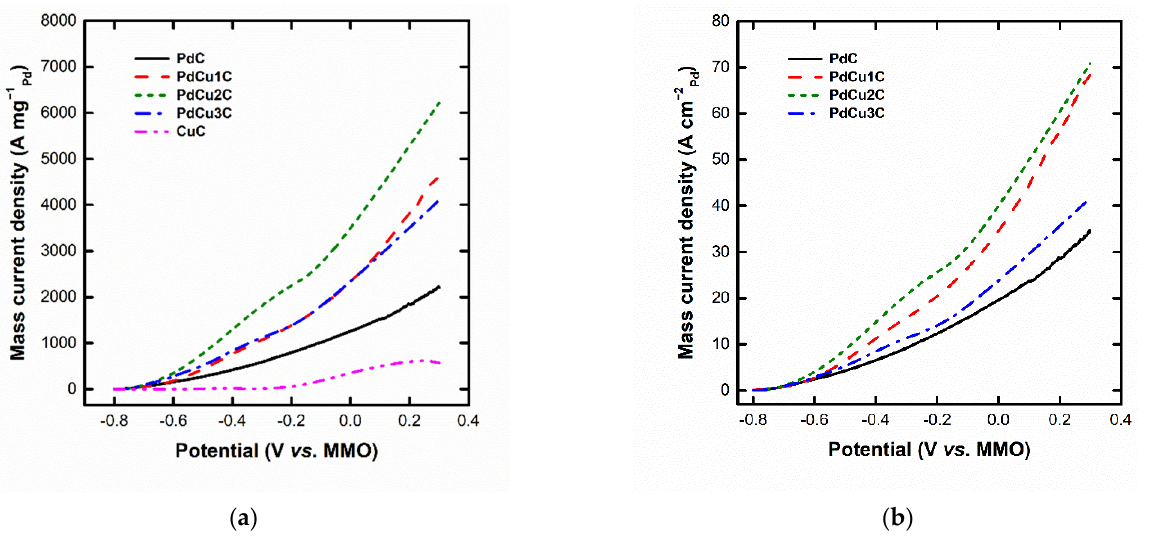
Figure 4. HYEOR linear sweep voltammograms profiles of the catalysts in 1 mol L − 1 N 2 H 4 and 1 mol L − 1 KOH normalized to: ( a ) mass of Pd; and ( b ) EASA of Pd.